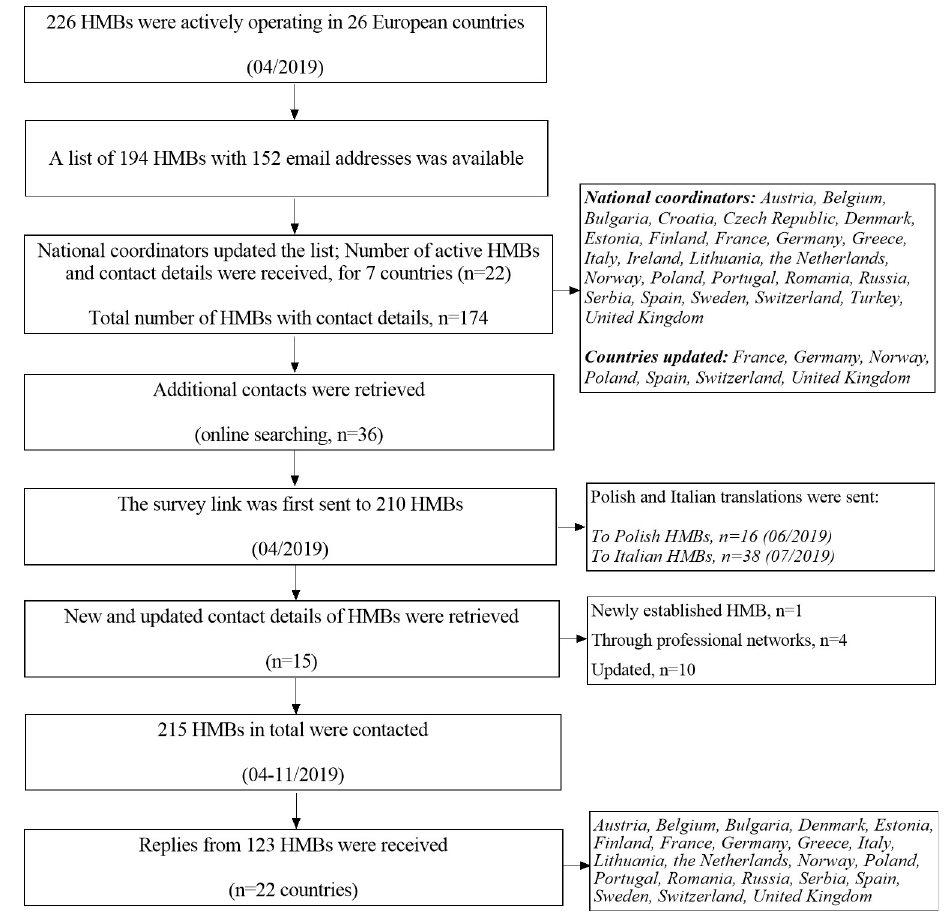
Fig 1. Schematic chart indicating participant